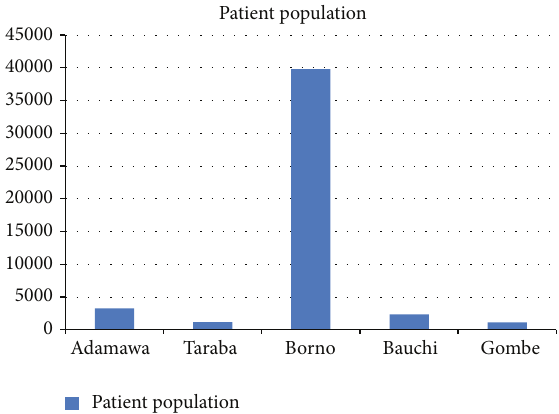
Figure 1: Patient populations across the region over the last decade.